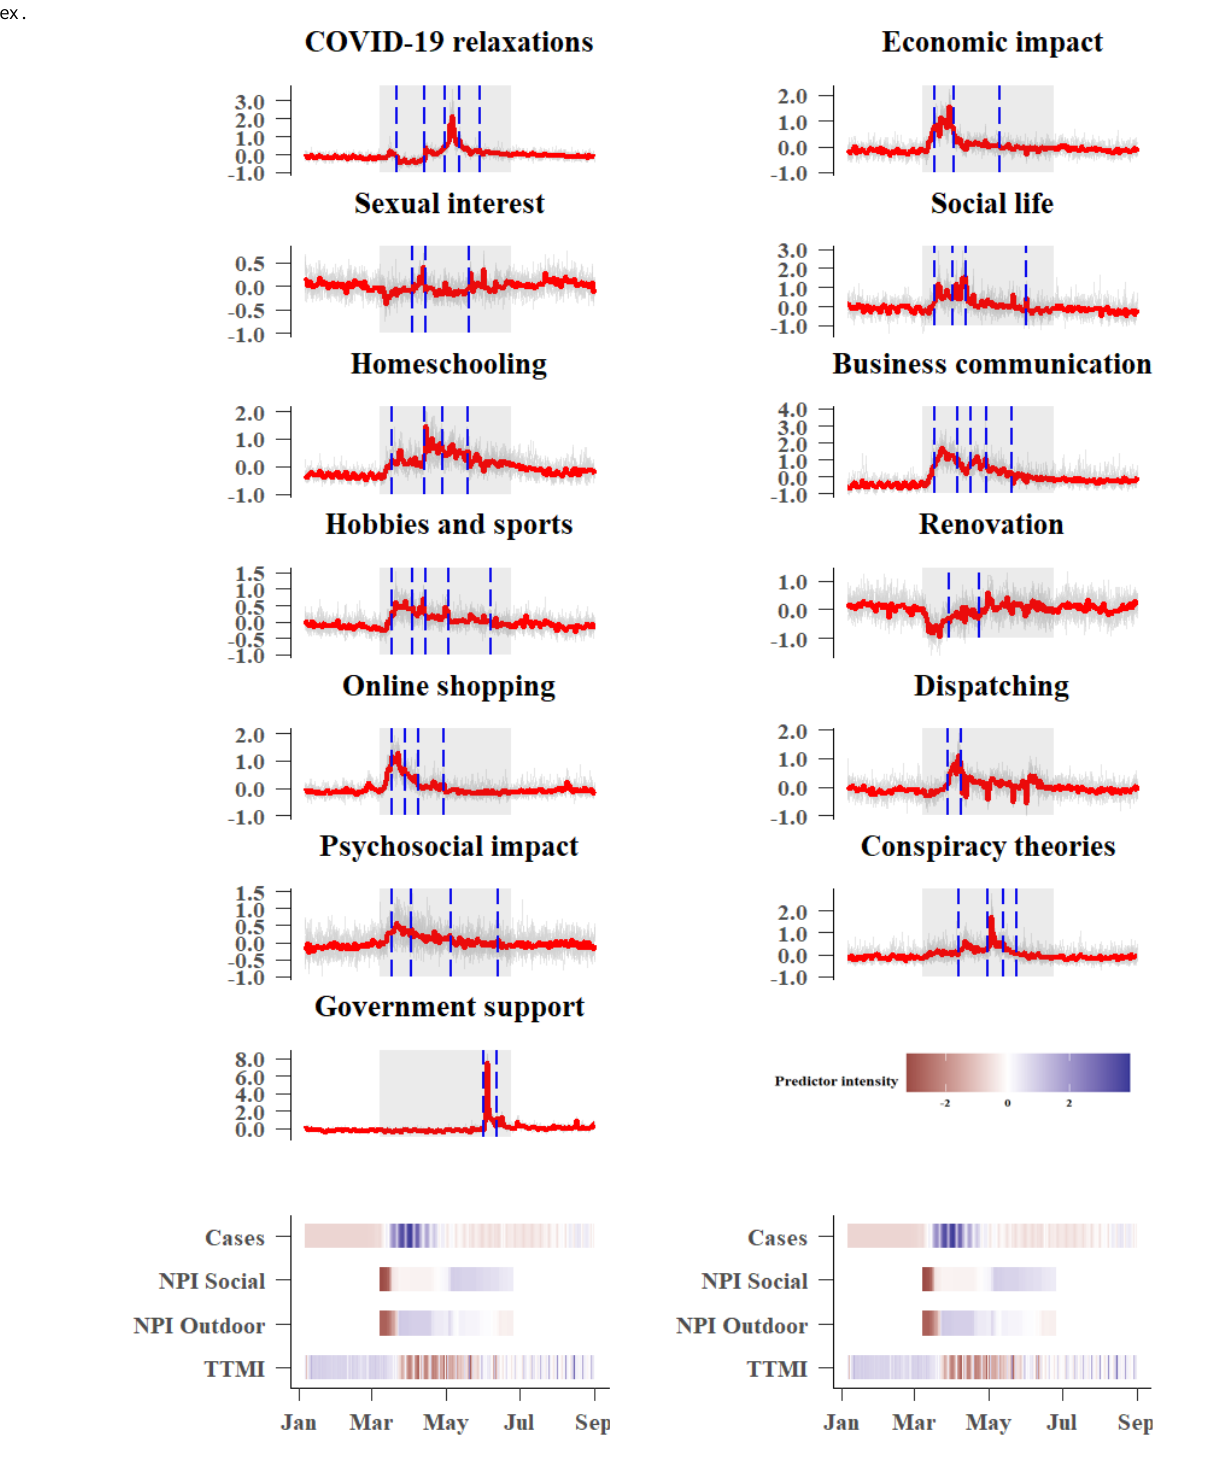
Figure 3. Z-standardized Google Trends for 13 additional domains. The red function indicates the trend for Germany, while the grey functions correspond to the trends for the 16 federal states. The grey shaded area represents the lockdown period in Germany from March 8 to June 26, 2020. Change points, indicating level changes, are represented by the vertical blue dashed lines. The intensity of daily new infections (Cases), countermeasures (NPI Social and NPI Outdoor), and the proxy for the state of economy (TTMI) are plotted below. NPI: nonpharmaceutical intervention; TTMI: truck toll mileage